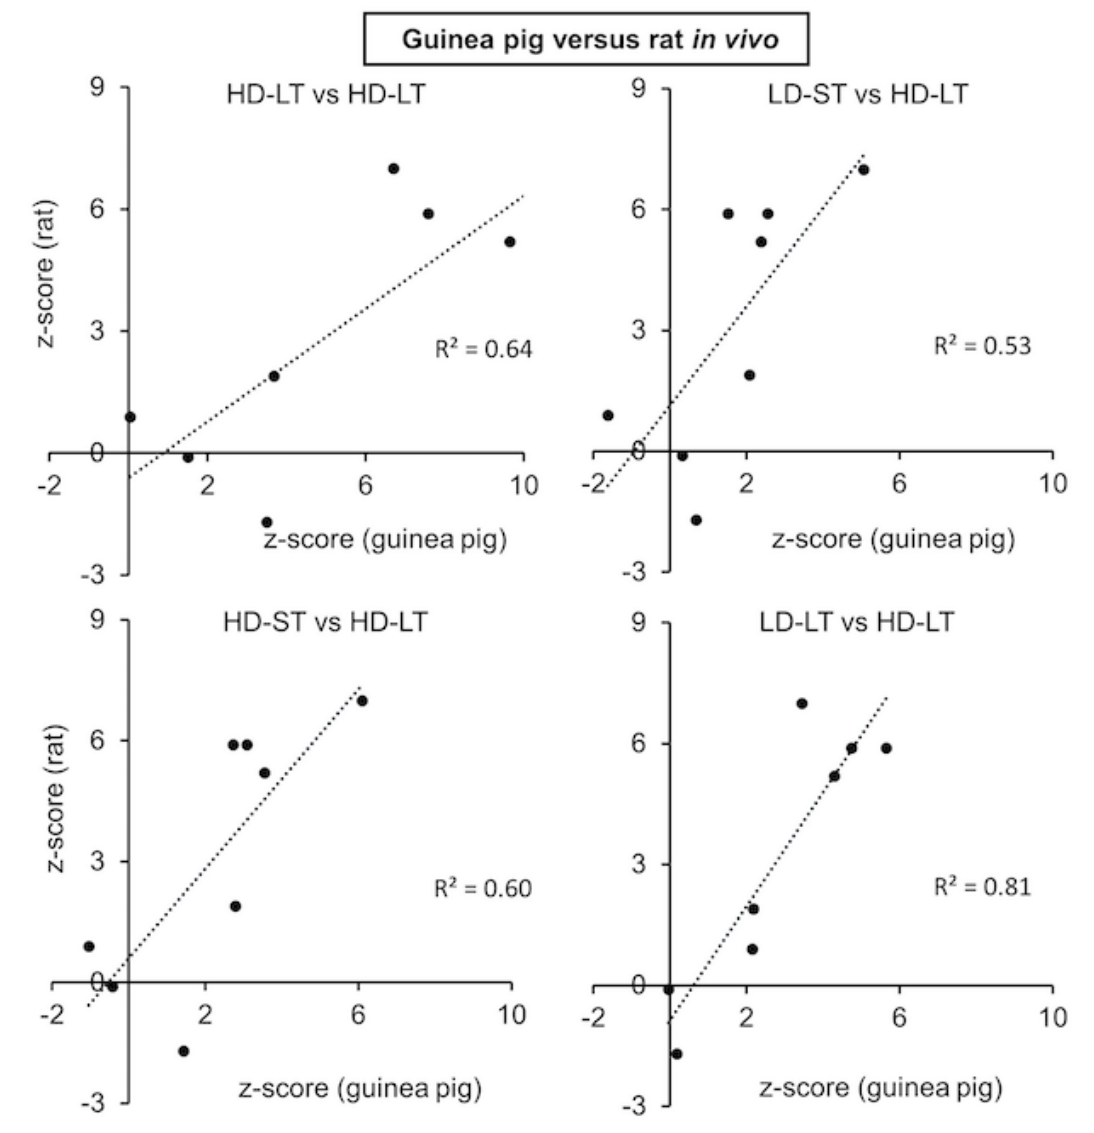
Figure 4. Correlation between the kidney injury modules for guinea pig versus rat in vivo data.